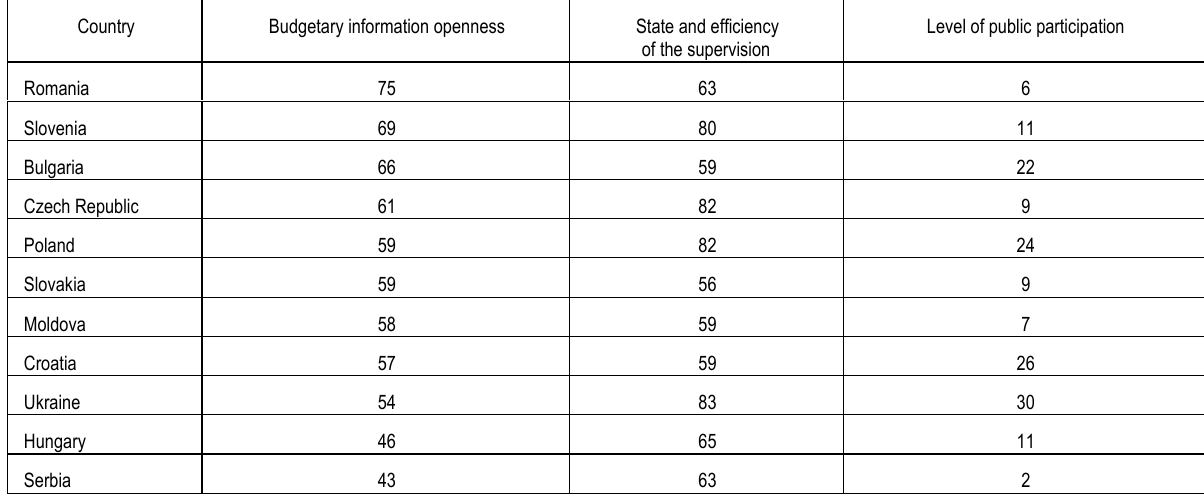
Table 2. Assessment of budget transparency of Eastern European countries for 2017 Country Budgetary information